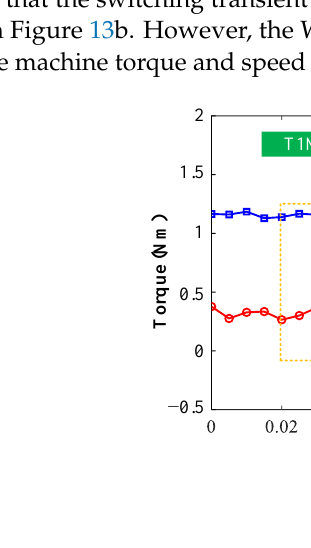
Figure 13. On-load WS transient characteristics from T1M2 to T1M3. ( a ) Line voltage and phase current waveforms. ( b ) Torque and speed curves.